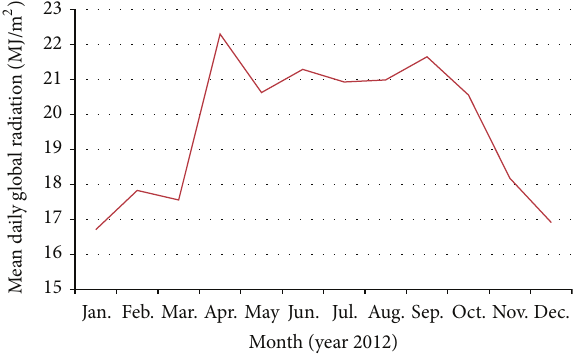
Figure 3: Monthly mean ambient temperature and mean daily global radiation for the year 2012 at KLIA, Sepang, Malaysia.